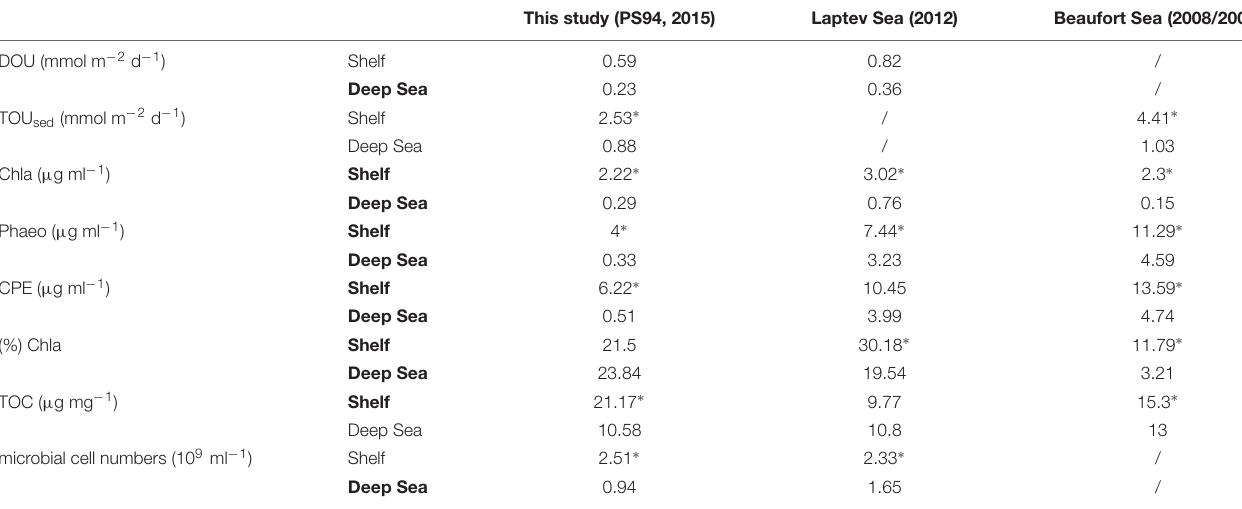
Mean values were calculated based on stations and per each subarea. Bold letters indicate that significant (p < 0.05) differences between the regions were found, whereas an asterisk indicates significant differences between shelf and deep-sea habitats. TOU sed , total oxygen uptake; DOU, diffusive oxygen uptake; CPE, chloroplastic pigment equivalent; TOC, sediment total organic carbon content; Chl a, sediment chlorophyll a concentration; Phaeo, sediment phaeopigment concentration; FOU, Fauna mediated oxygen uptake.